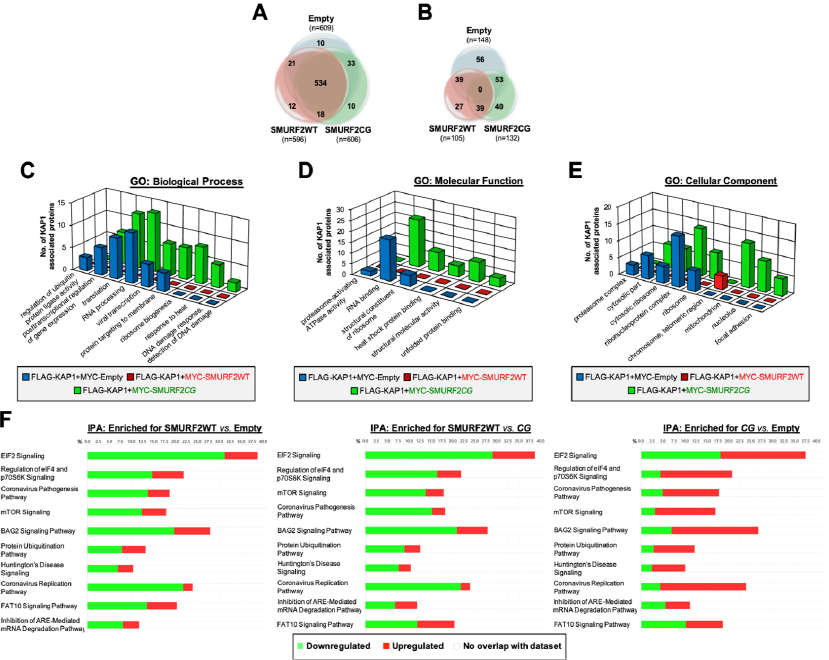
Figure 6. SMURF2 influences KAP1 interactome, regulating its functions in an E3 ligase ‐ dependent manner. ( A ) Venn diagram showing a total number of KAP1 ‐ associated proteins (n) identified in HEK ‐ 293T cells using MS. All identified peptides were filtered with FDR ≤ 1%, top rank, mass accu ‐ racy and a minimum coverage of two peptides. ( B ) Number of KAP1 ‐ associated proteins which abundance changed ≥ 2 ‐ fold. ( C – E ) GO analysis of biological processes (panel C), molecular func ‐ tions (panel D), and cellular components (panel E) of KAP1 ‐ interacting partners affected by SMURF2. GO terms were considered significant when showing Benjamini and Hochberg adjusted FDR (q ‐ value FDR B&H) < 0.05. The detailed results are shown in Table S4. ( F ) KAP1 interactome analysis using IPA. Top ten signaling pathways with the highest − log( p ‐ value) are shown. The de ‐ tailed list/analysis of all signaling pathways predicted to be altered by SMURF2WT vs. SMURF2 CG and control empty vector samples are shown in Table S5.